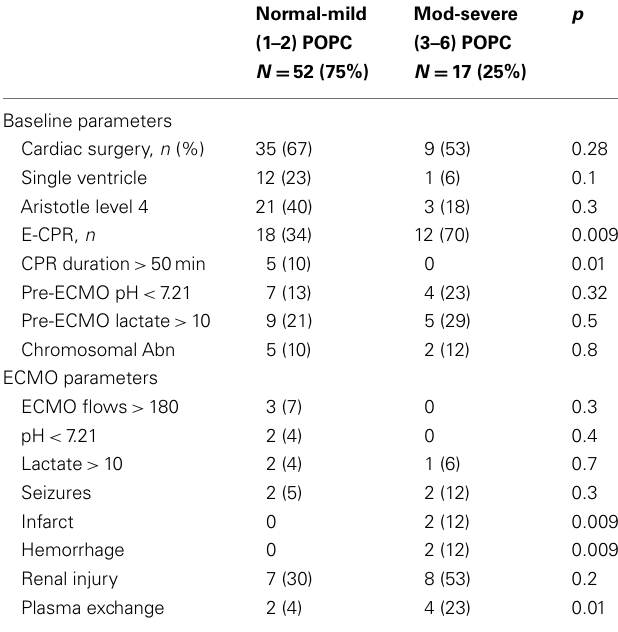
Table 7 | Comparison of patients with good – mild